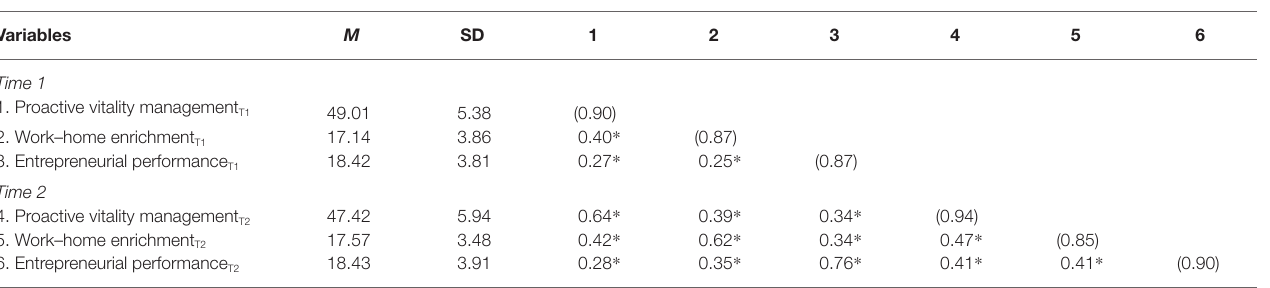
TABLE 1 | Means, standard deviations, correlation coefficients, and reliability coefficients table.